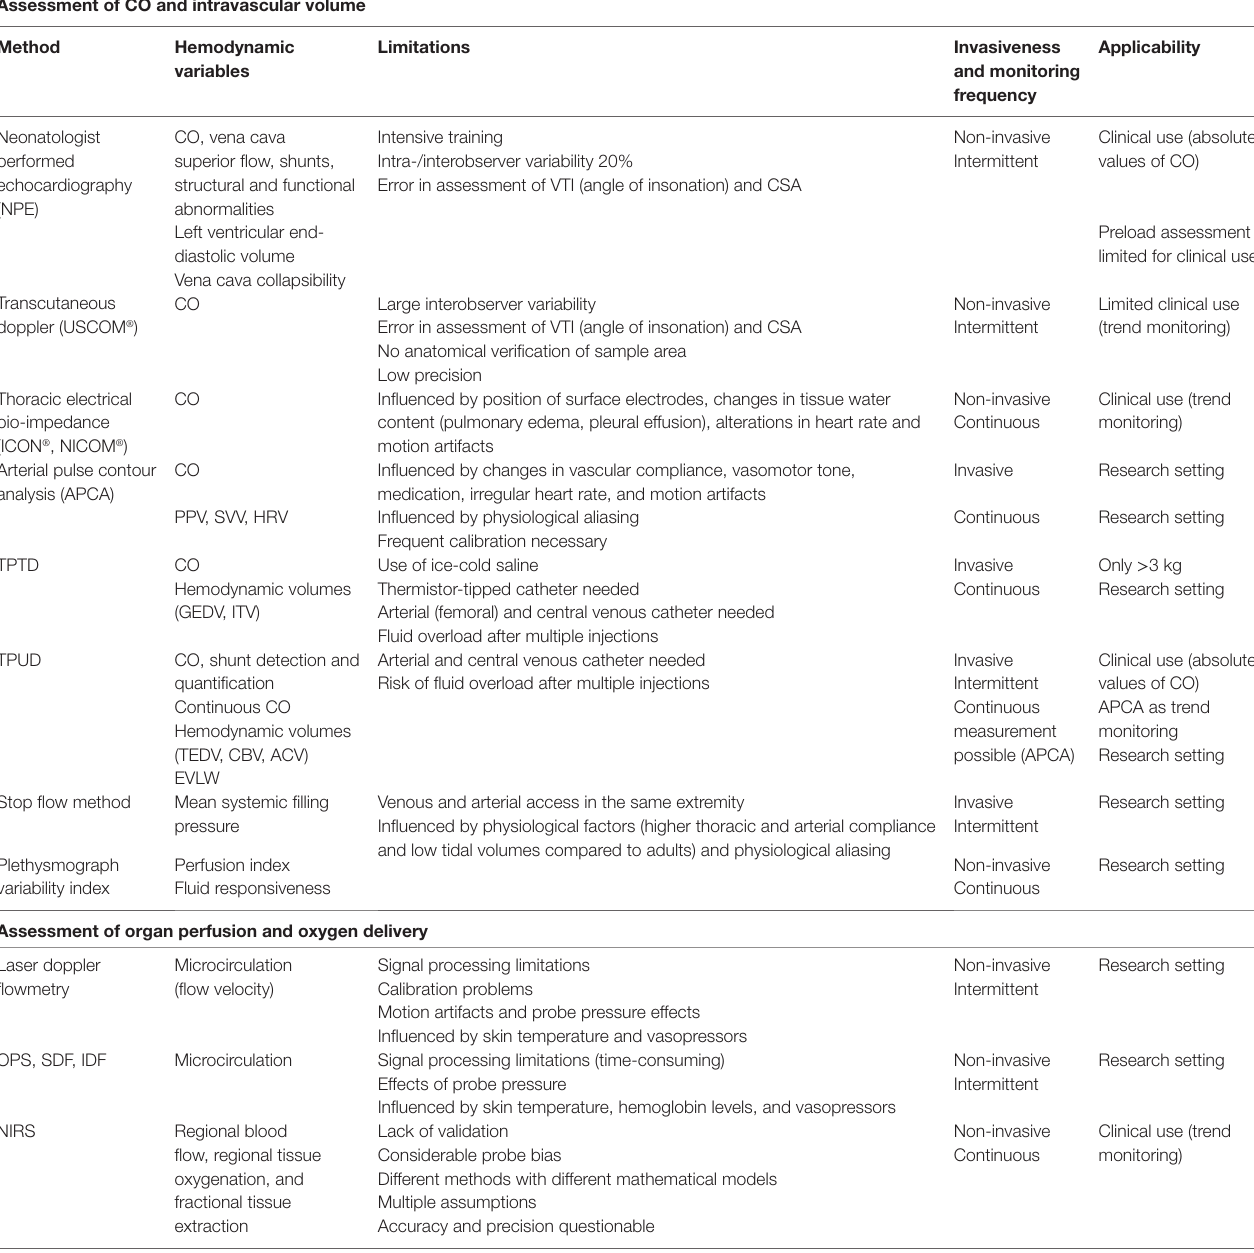
TABLe 1 | Advanced hemodynamic monitoring in